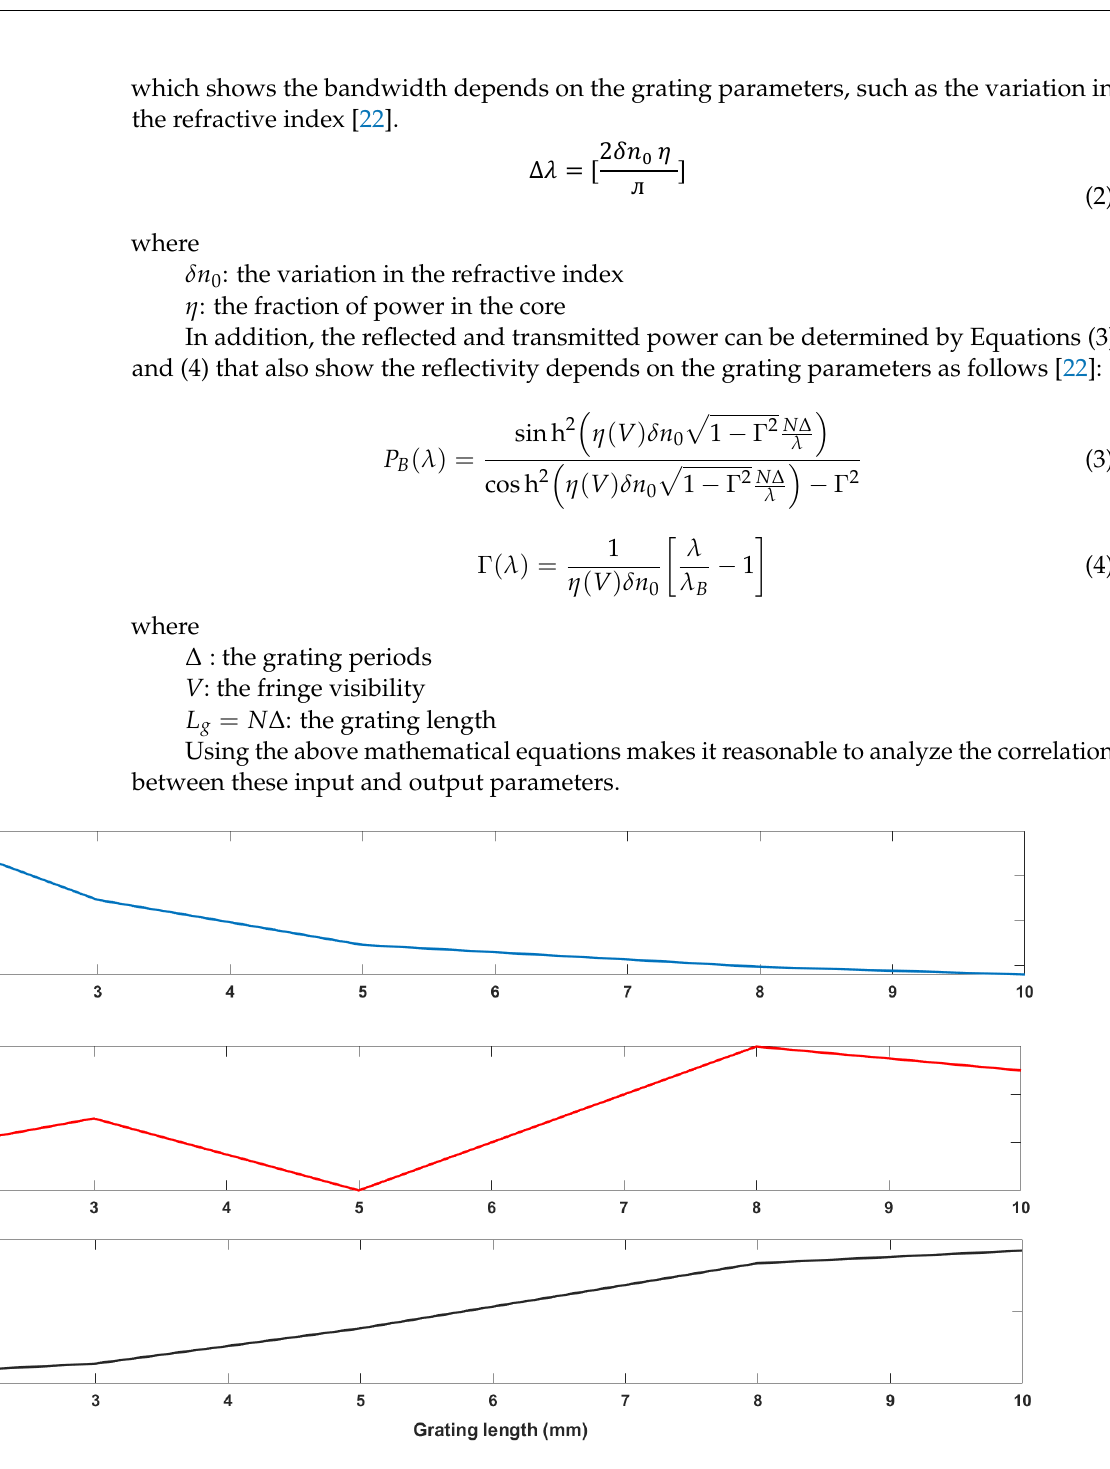
Figure 1. The effect of changing grating parameters on reflectivity and bandwidth [22].